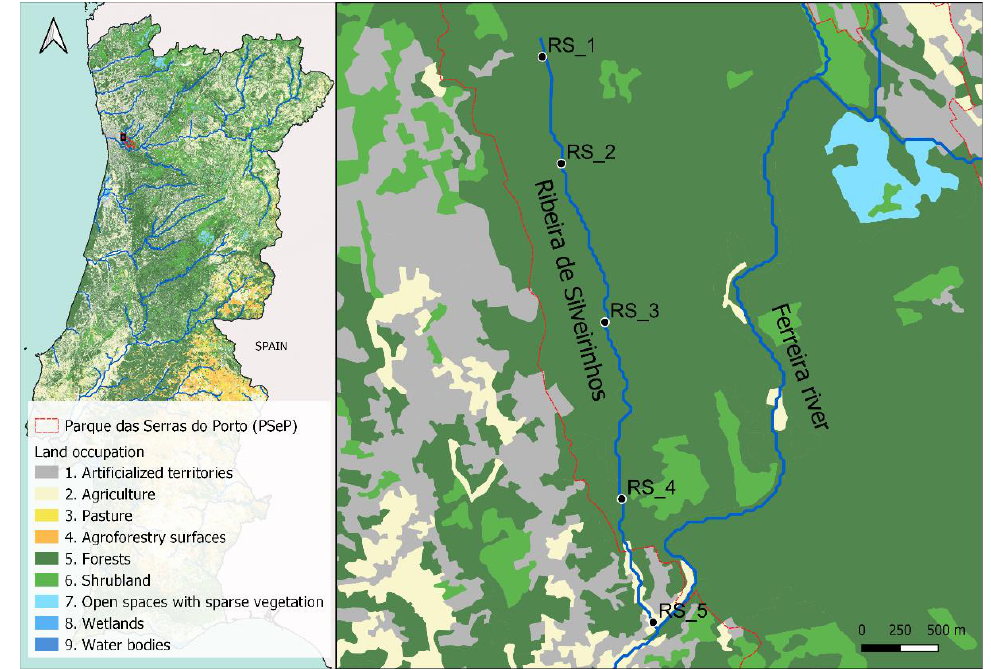
Figure 1. Location of Ribeira de Silveirinhos in Parque das Serras do Porto (PSeP), Portugal, and the five sampling sites selected for this study [RS_1(41 ◦ 10 (cid:48) 22.58 (cid:48)(cid:48) N; 8 ◦ 30 (cid:48) 2.29 (cid:48)(cid:48) W); RS_2 (41 ◦ 9 (cid:48) 59.97 (cid:48)(cid:48) N; 8 ◦ 29 (cid:48) 56.85 (cid:48)(cid:48) W); RS_3 (41 ◦ 9 (cid:48) 26.40 (cid:48)(cid:48) N; 8 ◦ 29 (cid:48) 44.41 (cid:48)(cid:48) W); RS_4 (41 ◦ 8 (cid:48) 48.97 (cid:48)(cid:48) N; 8 ◦ 29 (cid:48) 39.50 (cid:48)(cid:48) W); RS_5 (41 ◦ 8 (cid:48) 22.86 (cid:48)(cid:48) N; 8 ◦ 29 (cid:48) 30.55 (cid:48)(cid:48) W)]. Different colors stand for discriminate the land occupation in the surrounding